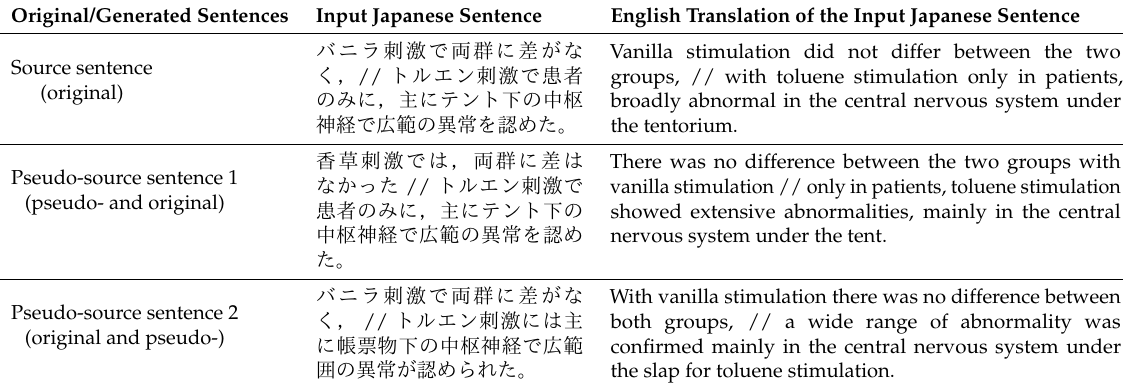
Table 1. Examples of an original source sentence and pseudo-source sentences with English translations. “//” denotes the splitting